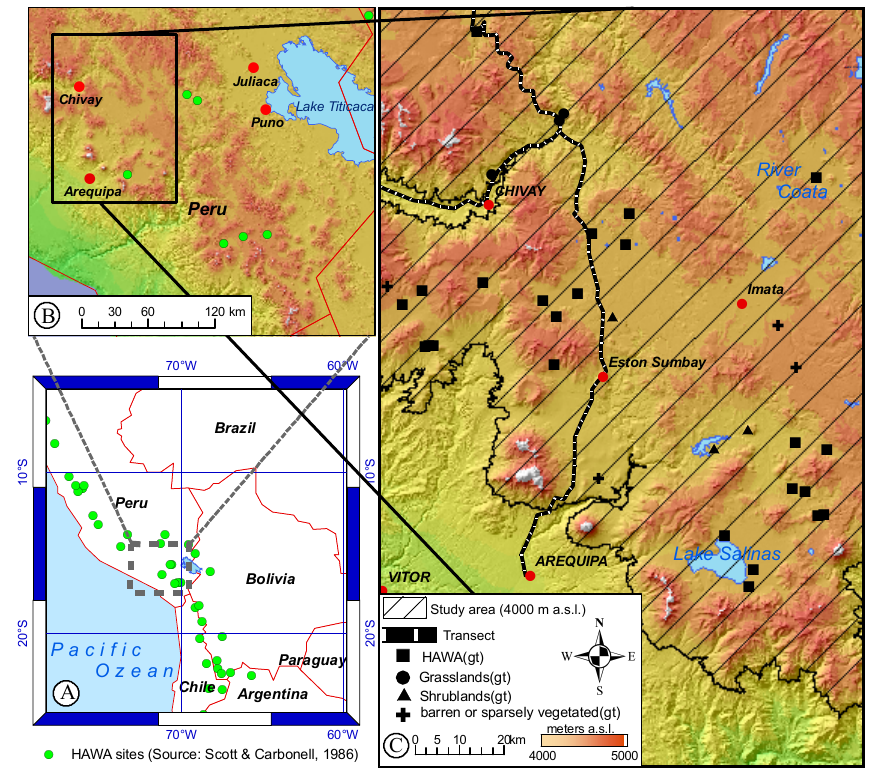
Fig. 1. Location of the study region within the known geographic range of HAWA (A, B) and ground-truth data (gt) above 4000ma.s.l. (C)